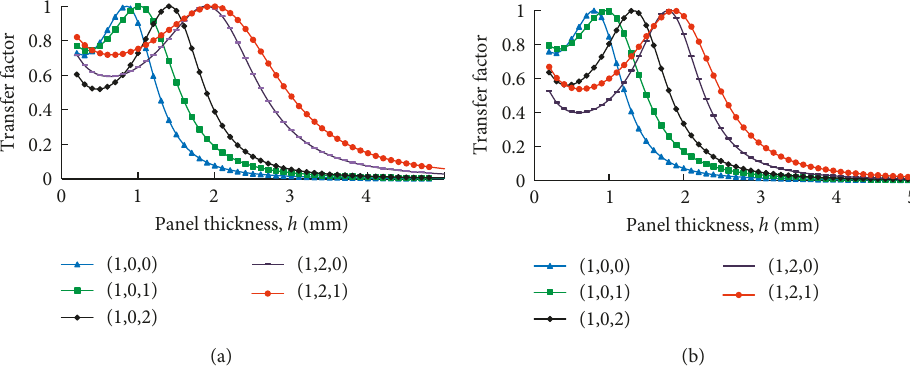
Figure 6: Effect of panel thickness on the coupling property of the panel-enclosure coupled system with different panel boundary conditions: panel mode (2,3). (a) Simply supported panel mode (2,3). (b) Clamped panel mode (2,3).